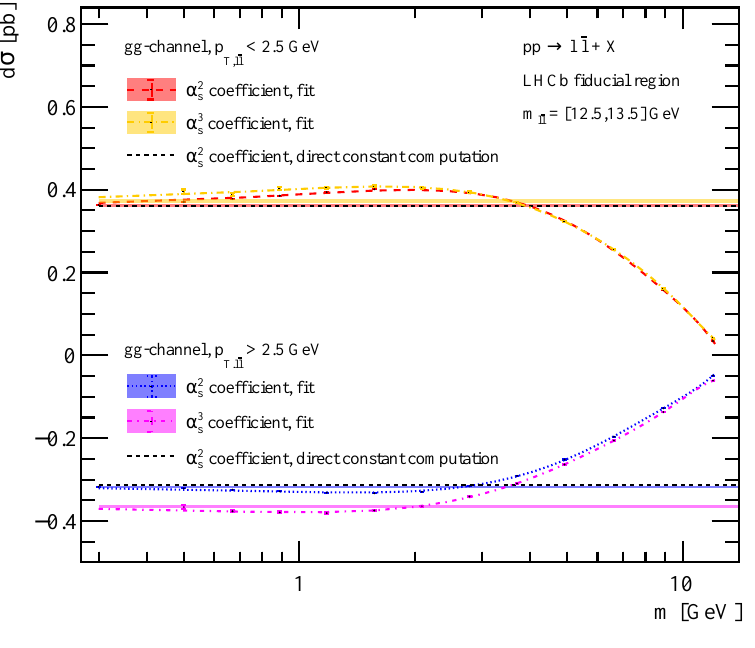
Figure 2: The same as the lower panel of Fig. 1, focussing on the g g -channel in two p regions. The result of a numerical fit to the difference between the massive and T, (cid:96) ¯ (cid:96) logarithmic cross-sections is shown, and compared to the direct calculation of the ) zero mass constant at O ( α 2 s